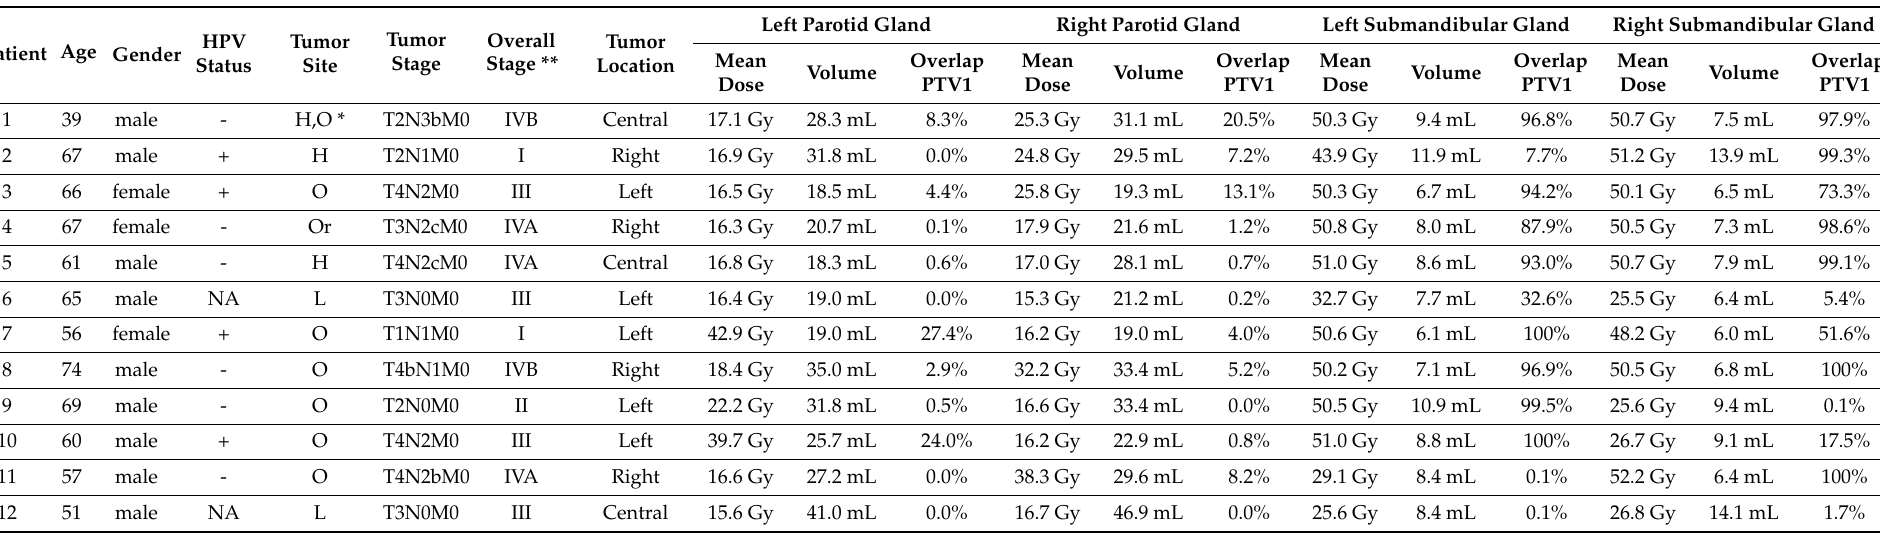
Table 1. Patient characteristics. * Two carcinomas, ** UICC TNM 8th edition. In case of a symmetric bilateral treatment of a centrally located tumor without clear lateralization, the term “central” was used. PTV = planning target volume, H = hypopharynx, O = oropharynx, L = larynx, Or = oral cavity, NA = not